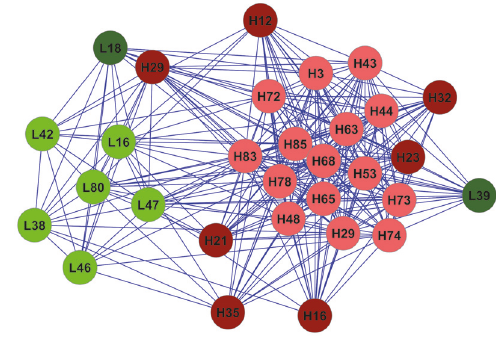
Figure 2: Prediction of seroresponse to TIV vaccination. The graph represents sample classification by means of the 207 transcripts biomarker. Nodes represent subjects and the length of connecting edges is proportional to the distance between subject signatures. Node colors indicate subjects’ class (green for low responders and red for high responders); darker colors represent samples included in the validation set (2007-2008 TIV campaign, set #1), while lighter colors represent samples in the training set (2008-2009 TIV campaign, set #2). Node labels indicate the sample class (H for high responders and L for low responders) and sample identifier.